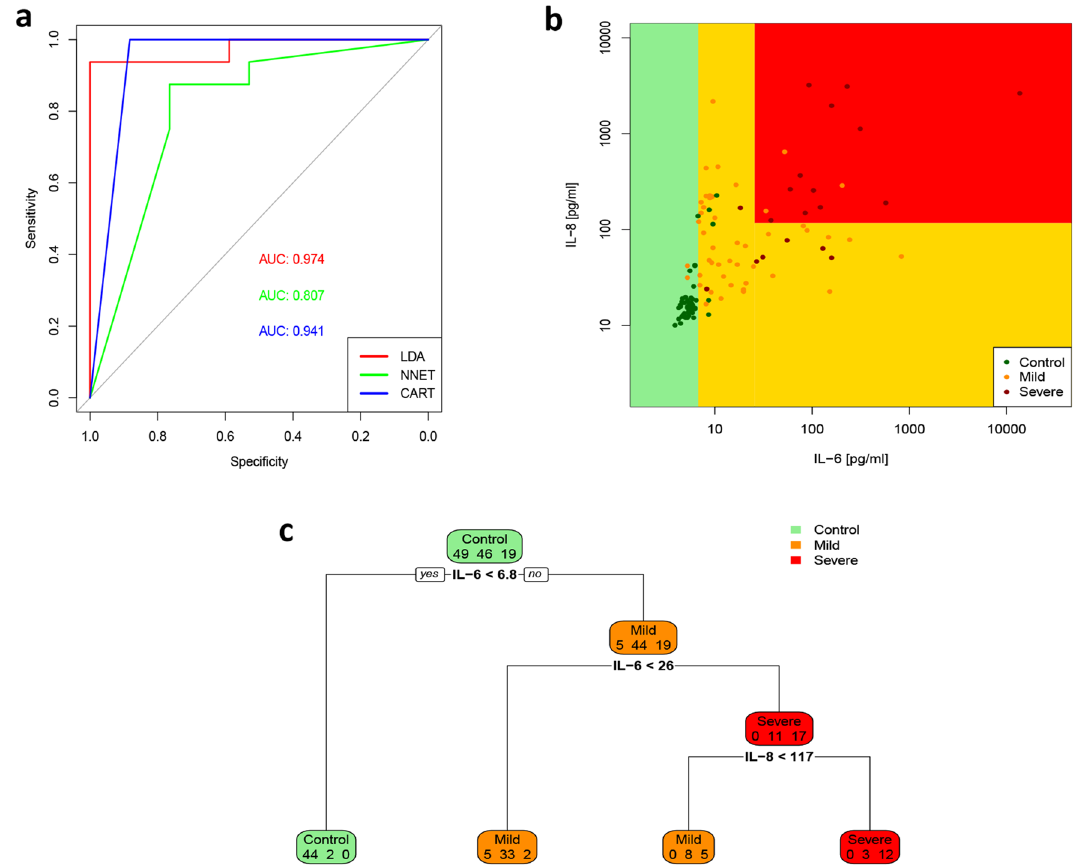
Figure 5. IL-6 and IL-8 performance in discriminating COVID-19 disease and severity. Comparison of classification accuracy of LDA, NNET and CART algorithms. AUC of ROC analysis indicates performance of the three classifier algorithms ( A ). Scatterplot from CART analysis identifies the groups labelled by their terminal nodes ( B ). The decision tree shows the rules and split points to estimate COVID-19 disease and severity. In each box, the first number estimates controls, the second number estimates mild COVID-19 patients, the third number severe COVID-19 patients. Decision binary tree reveals an optimal cut-off of IL-6 > 6.8 pg/ml for predicting COVID-19 disease and of IL-8 > 117 pg/ml for severity ( C